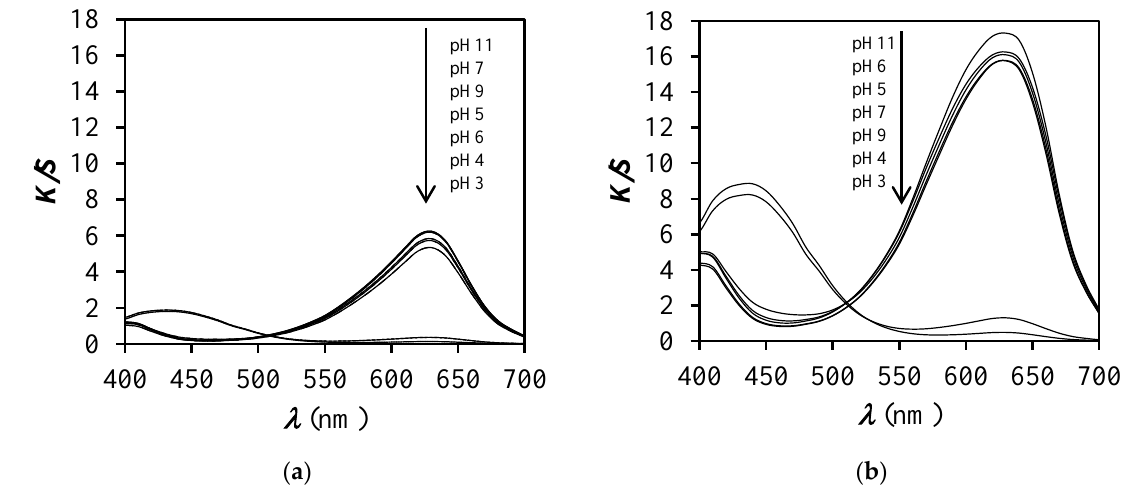
Figure 7. K/S values vs. wavelength ( λ ) for unfinished samples, dyed with dye concentration of 0.1% ( a ) and 0.5% o.m.f. ( b ), after immersion in buffer solutions of different pH values.